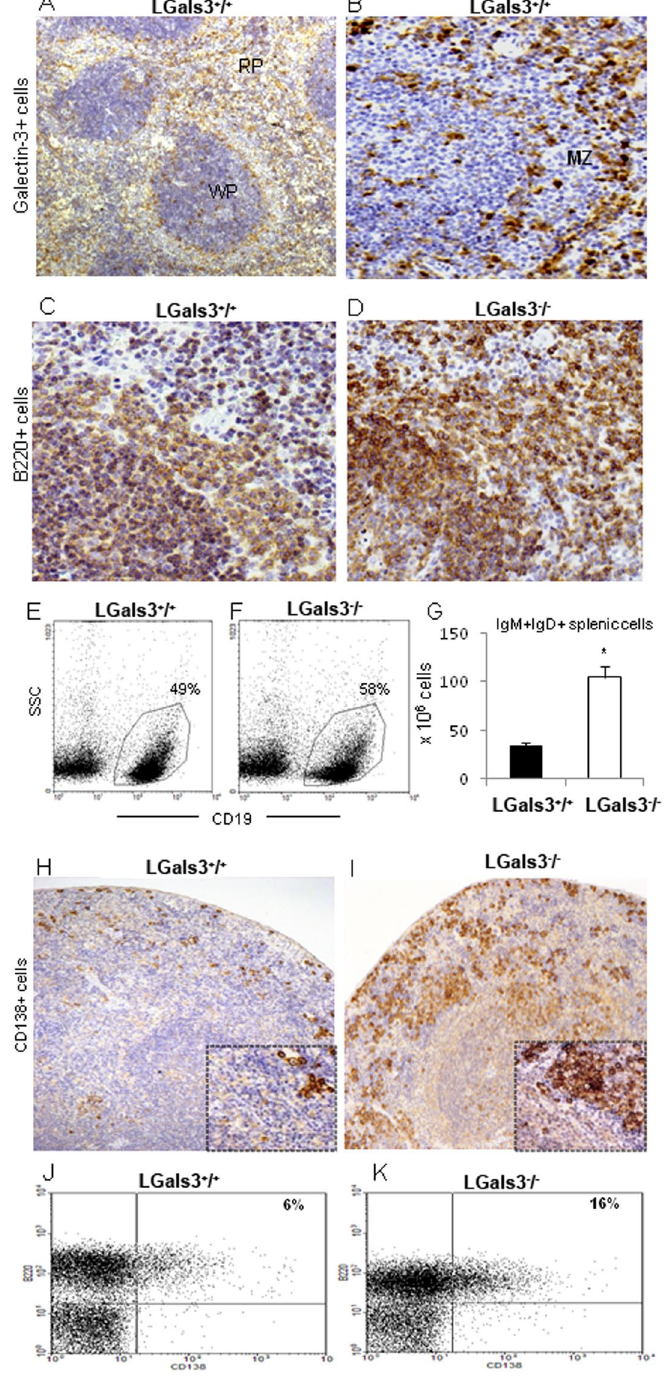
Figure 4. Histological analysis of the spleen. ( A ) Localization of galectin-3 + cells in the white (WP) and red pulp (RP). ( B ) In more details, galectin-3 + cells were located in the marginal zone (MZ). Both photomicrographs are representative of WT mice. B cell niches were hallmarked by B220 + B cells in MZ of Lgals3 + / + mice ( C ), but poorly identified in Lgals3 − / − mice ( D ). Identification of splenic CD19 + SSC low B cells in Lgals3 + / + ( E ) and Lgals3 − / − mice ( F ). ( G ) Quantity of IgM + IgD + B cells identified by flow cytometry. CD138 + plasma cells were located in the spleen of Lgals3 + / + ( H ) and Lgals3 − / − mice ( I ). Flow cytometry analysis revealed B220 + CD138 + plasmablasts in Lgals3 + / + and Lgals3 − / − mice ( J and K , respectively). n = 5 mice per group. Magnification: ( A , B ) 100 × ; ( C , D ) 200 × ; ( H , I ) 100 × . ( * ) Indicates p <